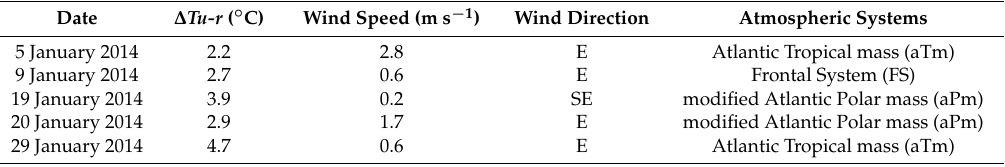
Table 2. Urban heat island magnitude and atmospheric systems during nighttime traverses in Rancharia, January 2014.